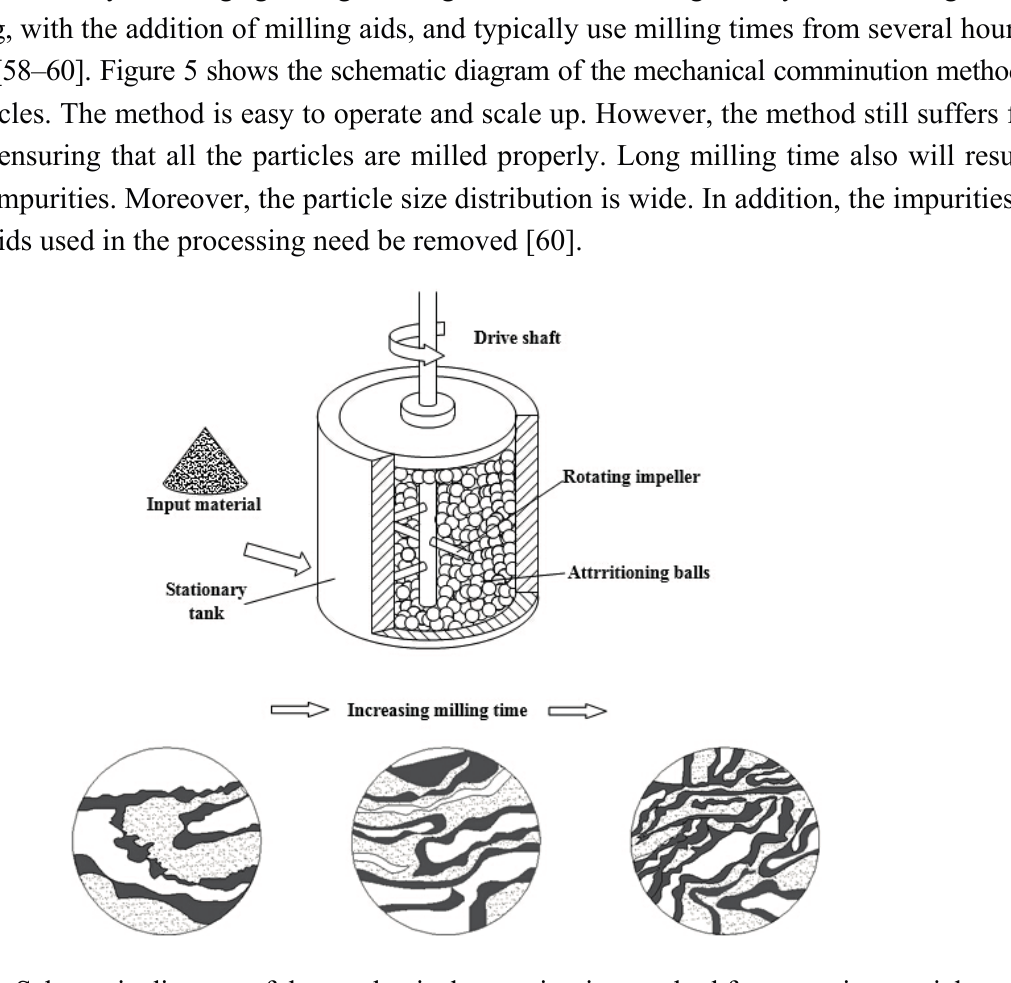
Figure 5. Schematic diagram of the mechanical comminution method for preparing